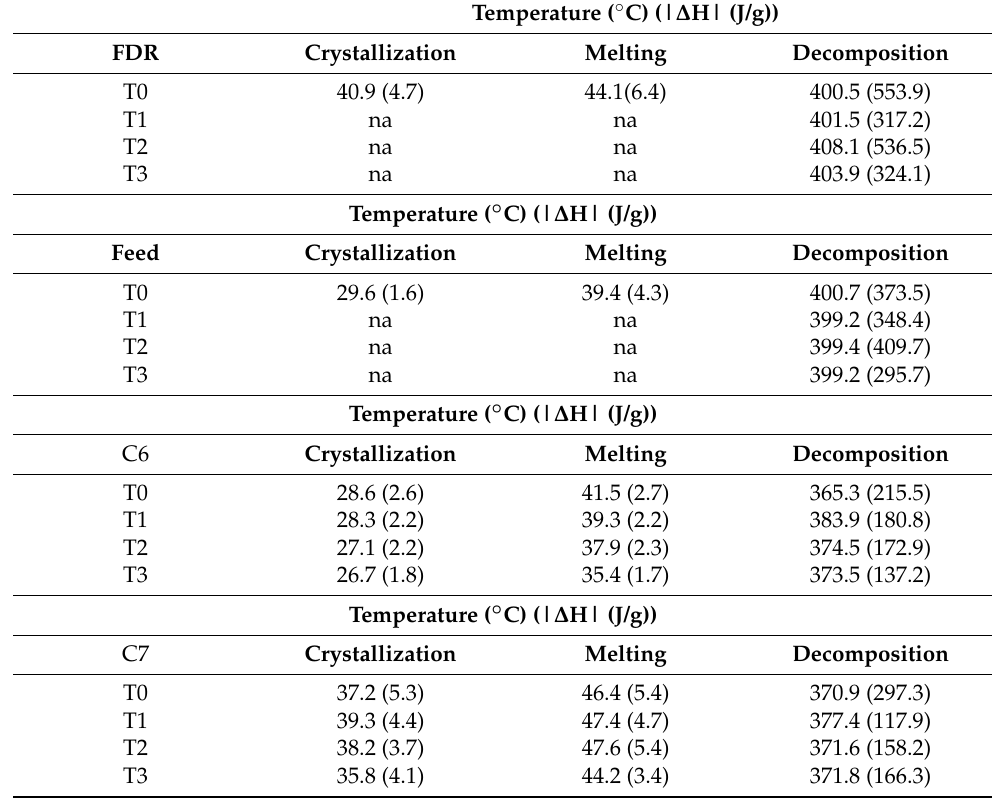
Table 5. Thermal characteristics (temperatures and enthalpies) of the study samples throughout the stability